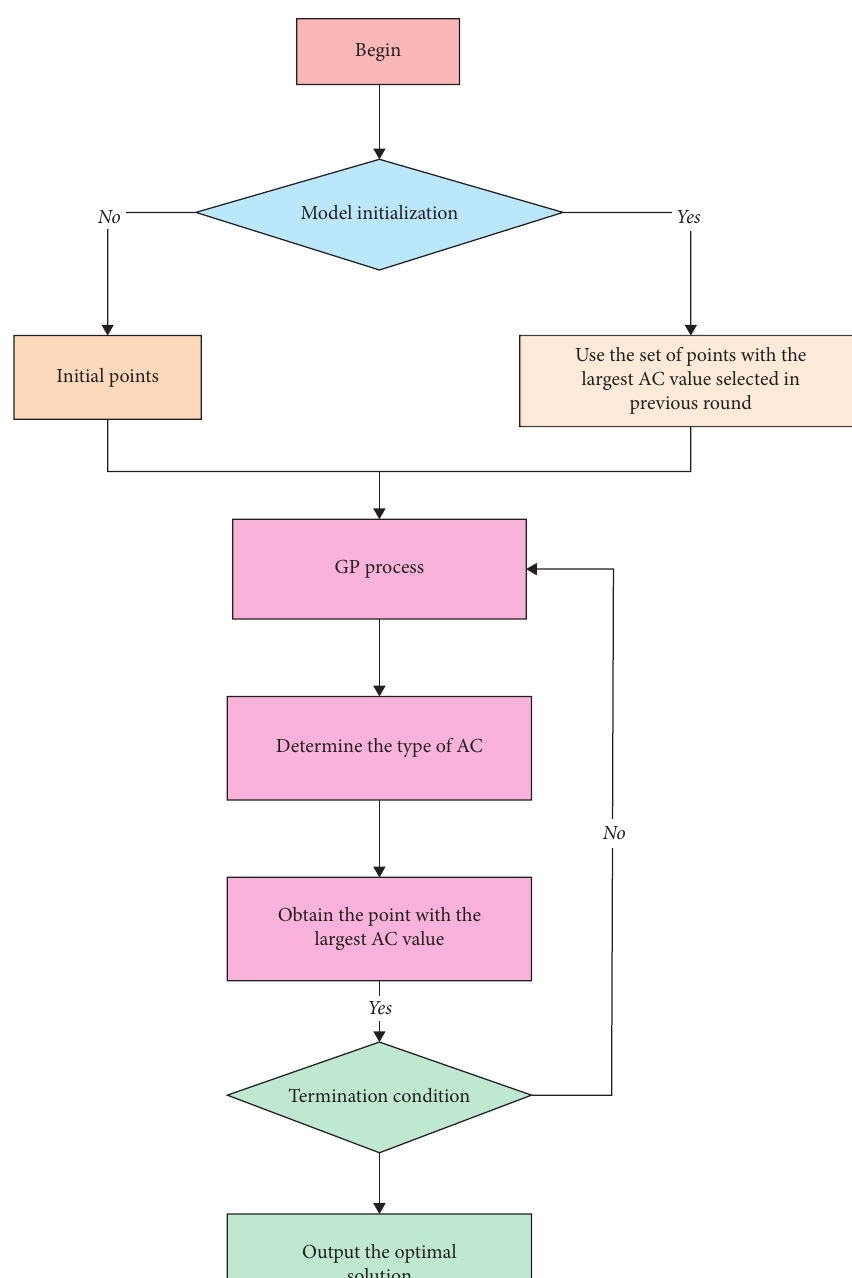
Figure 2: The flowchart of Bayesian